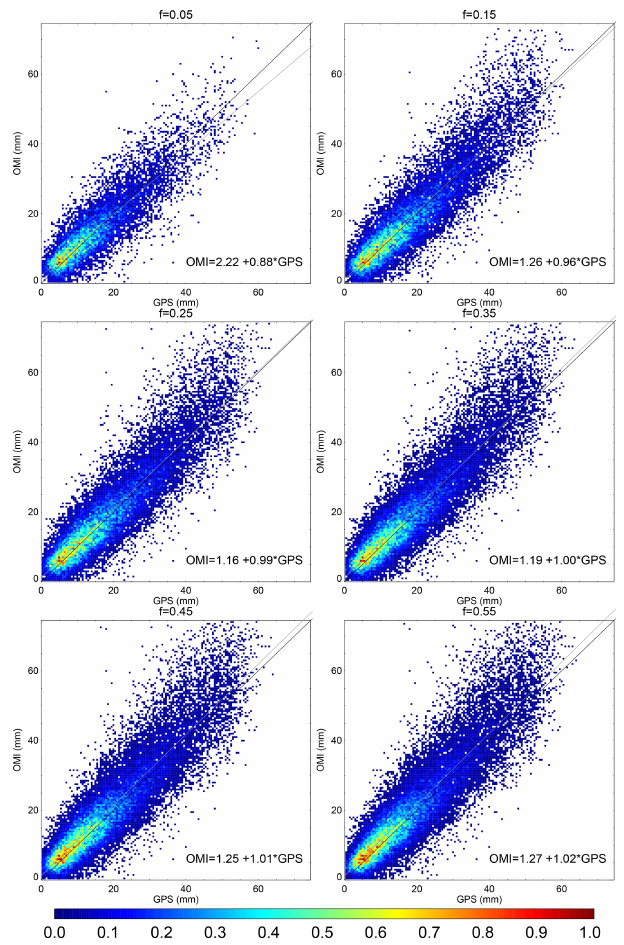
Figure 4. Normalized joint distributions of GPS versus version 4.0 OMI TCWV for different cloud fraction thresholds. Results are de- rived from the colocated data pairs for 2006. The OMI data filtering criteria are the same as those for Fig. 3. In each panel, the 1 : 1 line is plotted in black, and the linear regression line is plotted in gray and indicated by the formula in the lower right